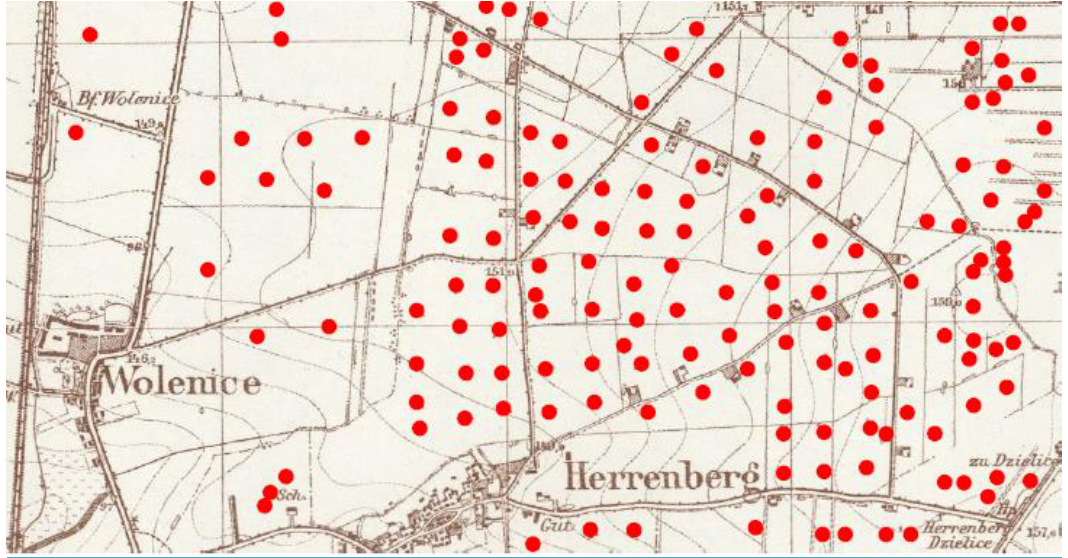
Figure 2: Distribution of PMH in large-sized fields – an example from the surroundings of Dzielice (Herrenberg) village (PMH are marked in red) Source: Messtichblatt, 4270 Bozacin, from 1888, scale 1:25,000, Archiwum Map Zachodniej